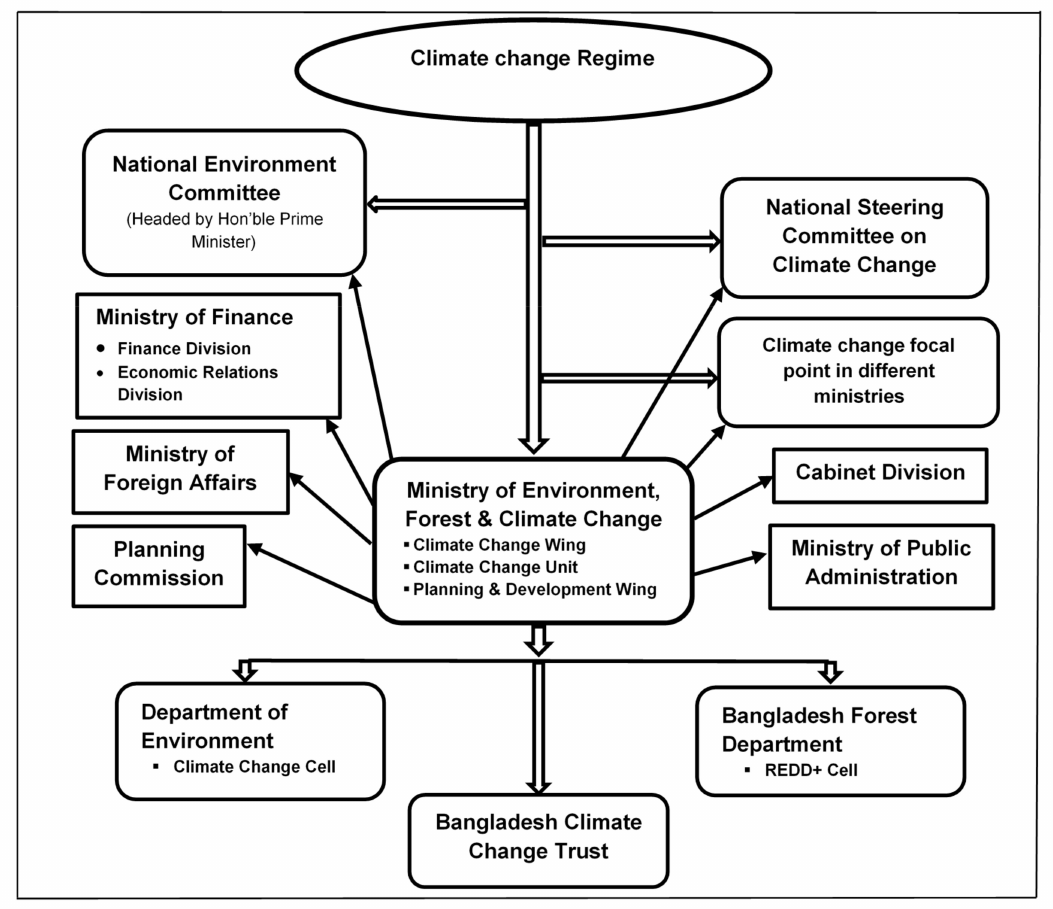
Figure 1. Functional administrative set up of climate change regime at the center in